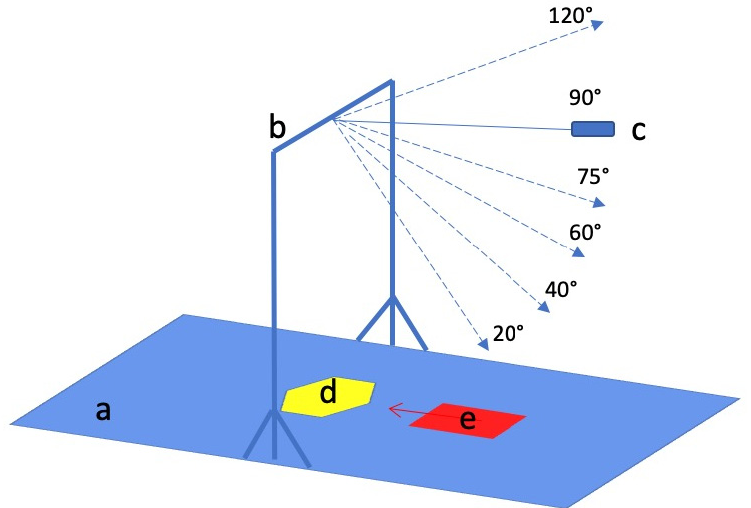
Figure 3. Schematic drawing of the pendulum testing device. ( a ) Pendulum testing device base-plate; ( b ) pendulum testing device frame; ( c ) pendulum; ( d ) stainless steel upper jaw model; ( e ) triangulation laser sensor. Dotted lines mark deflection angles used for different energy impact.